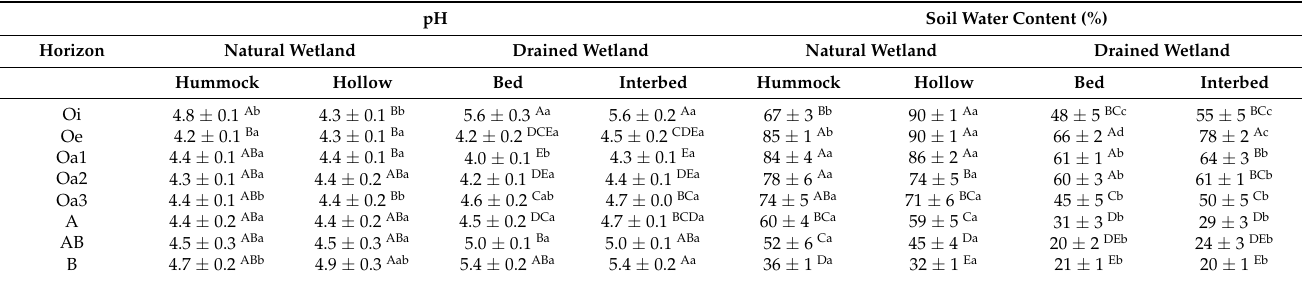
Table 1. Soil pH and water content (%) for samples collected from organic and mineral horizons of a natural coastal freshwater forested wetland (Natural Wetland) and an intensively managed loblolly pine plantation (Drained Wetland) in coastal North Carolina, USA. Data represent means with standard error ( n = 5). Significant differences between soil horizons at each site and sampling location are indicated by superscript upper-case letters ( p < 0.05). Significant differences between each site and micro-topographic location (e.g., hummock, hollow, bed, or interbed) at each soil horizon are indicated by superscript lower-case letters ( p < 0.05). pH Soil Water Content (%)